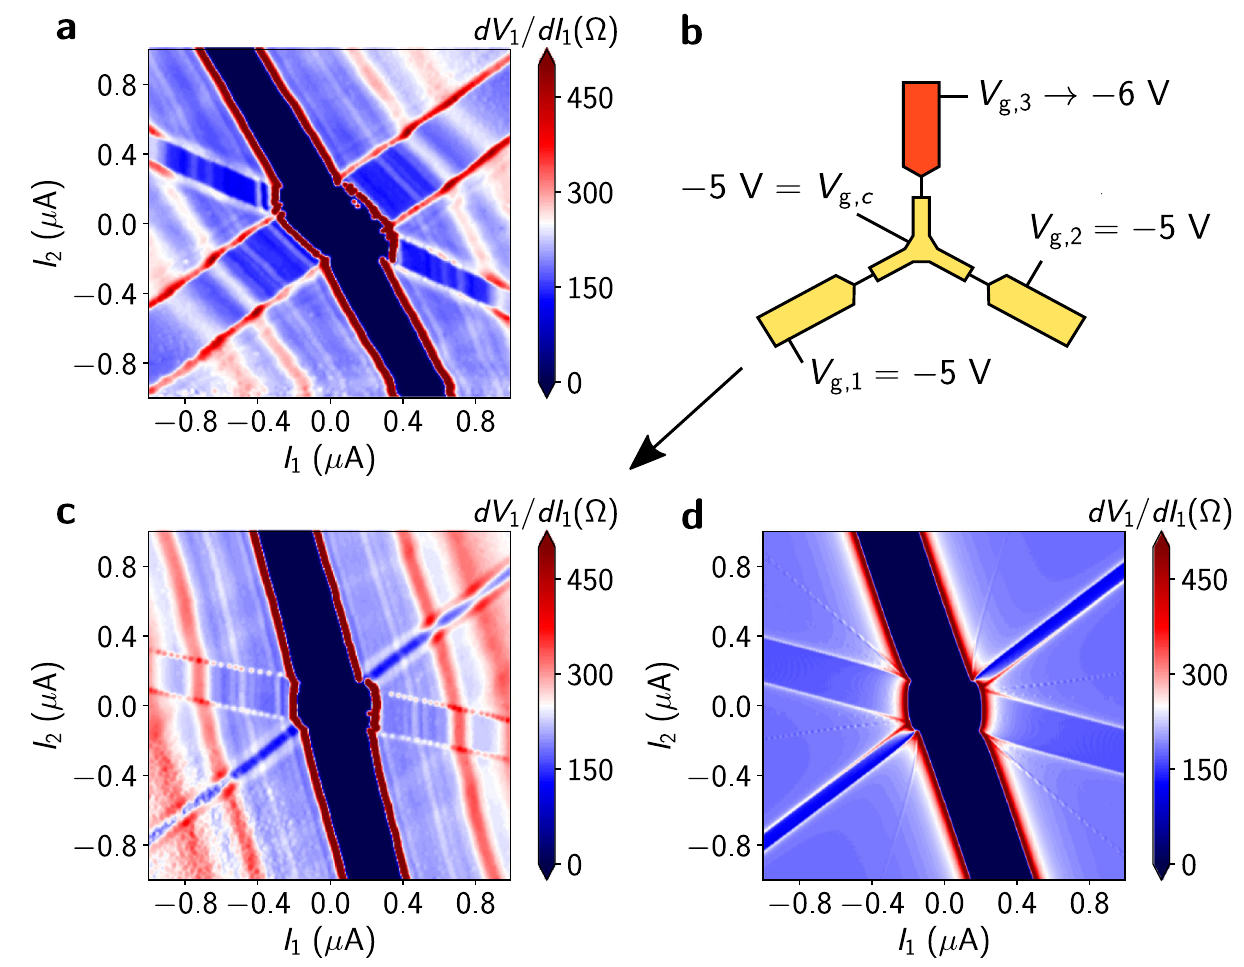
Fig. 3 | Selective gating. a Measurement of dV 1 / dI 1 on Device 2, B =0, T ~90mK with V g, c , V g,1 , V g,2 , V g,3 = − 5V. b Schematic of gate con fi guration for the selective gating of the junction leg between terminals 1 and 2. c Measurement of dV 1 / dI 1